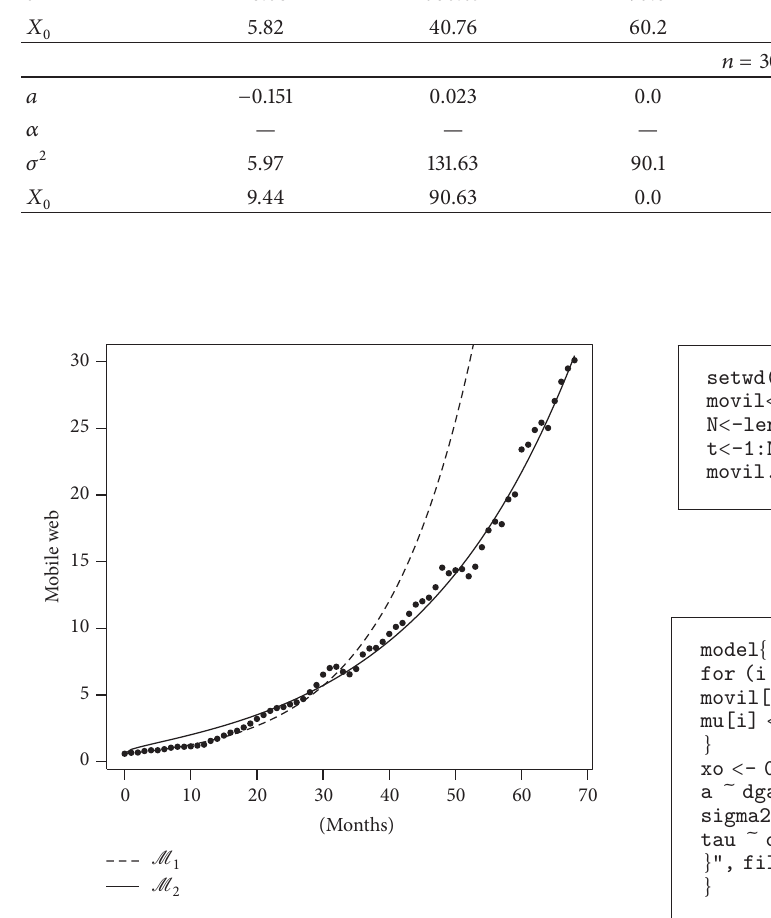
Figure 2: Mobile web (in percentage) from December 2008 to August